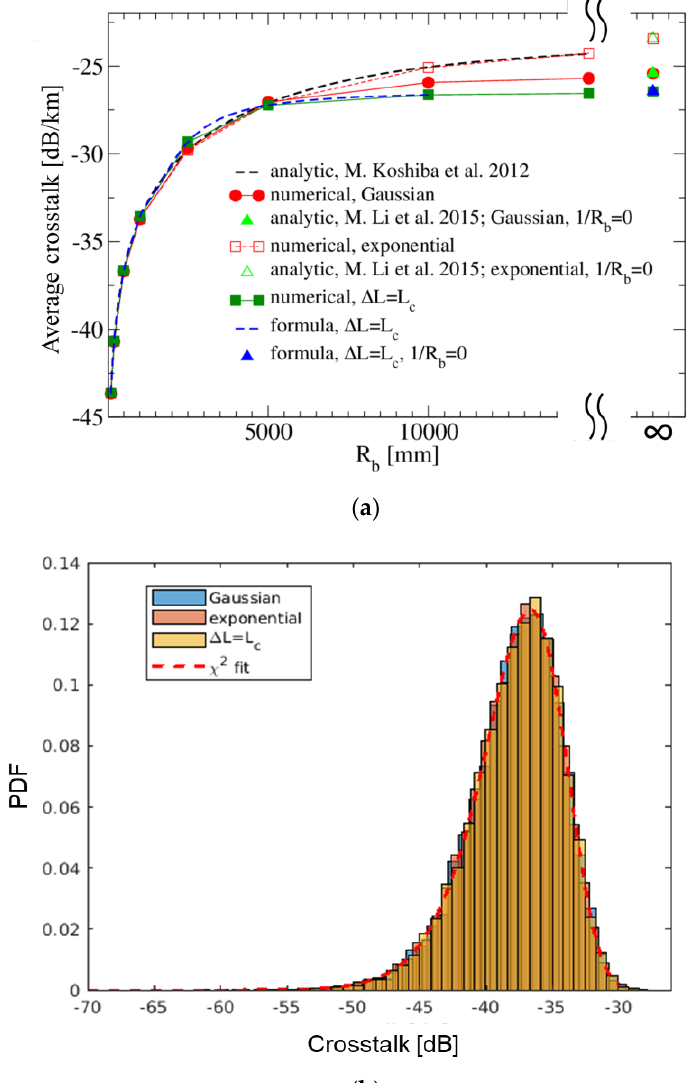
Figure 8. ( a ) Average crosstalk dependence on the bend radius, computed numerically and based on analytic approaches of M. Koshiba et al. 2012 [11], M. Li et al. 2015 [8] and Equation (15); ( b ) simulated crosstalk probability density functions for homogeneous MCF at R b = 500 mm in compar- ison to the χ 2 -distribution